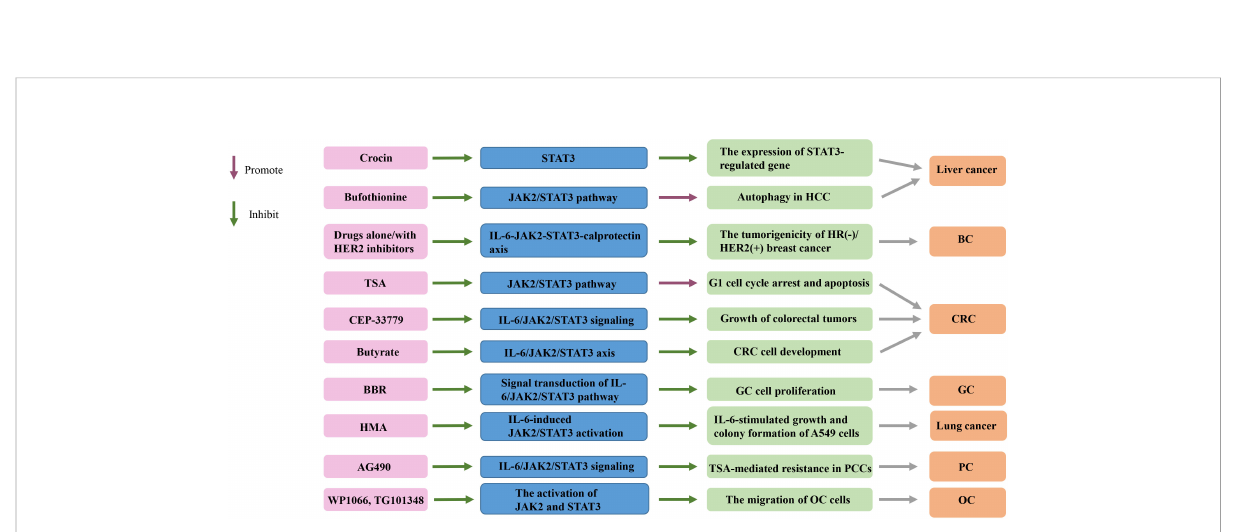
FIGURE 2 Targeting the IL-6/JAK2/STAT3 signaling pathway in cancers. TSA, trichostatin A; BBR, Berberine; HMA, 2-hydroxy-3-methylanthraquinone; HCC, hepatocellular carcinoma; HR, hormone receptor; HER2+, HER2-positive; CRC, colorectal cancer; GC, gastric cancer; PCCs, pancreatic cancer cells; OC, ovarian cancer; BC, breast